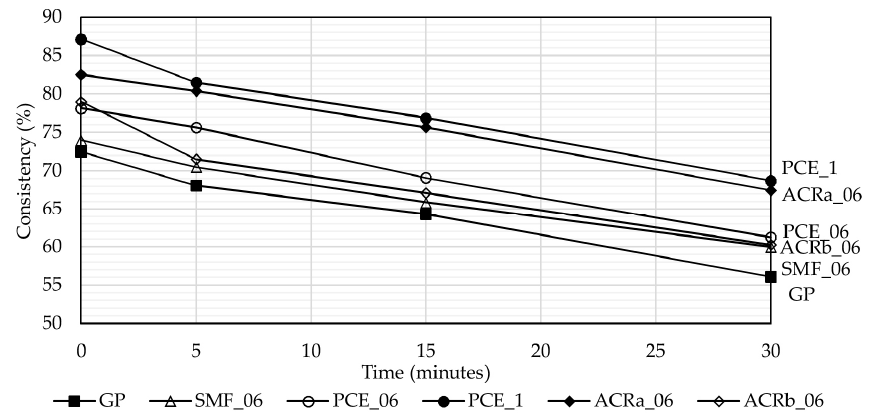
Figure 2. Consistency of geopolymer mortars as function of time (average of four measurements). Standard deviation ( δ ) is not reported in the plot for clarity’s sake however it is in the range of ±5.